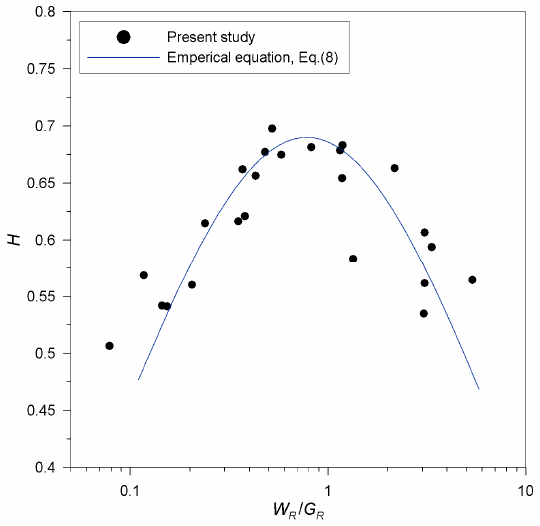
Figure 9. Relationship between harmony ( H ) and ratio of water to greenery ( W R / G R ).